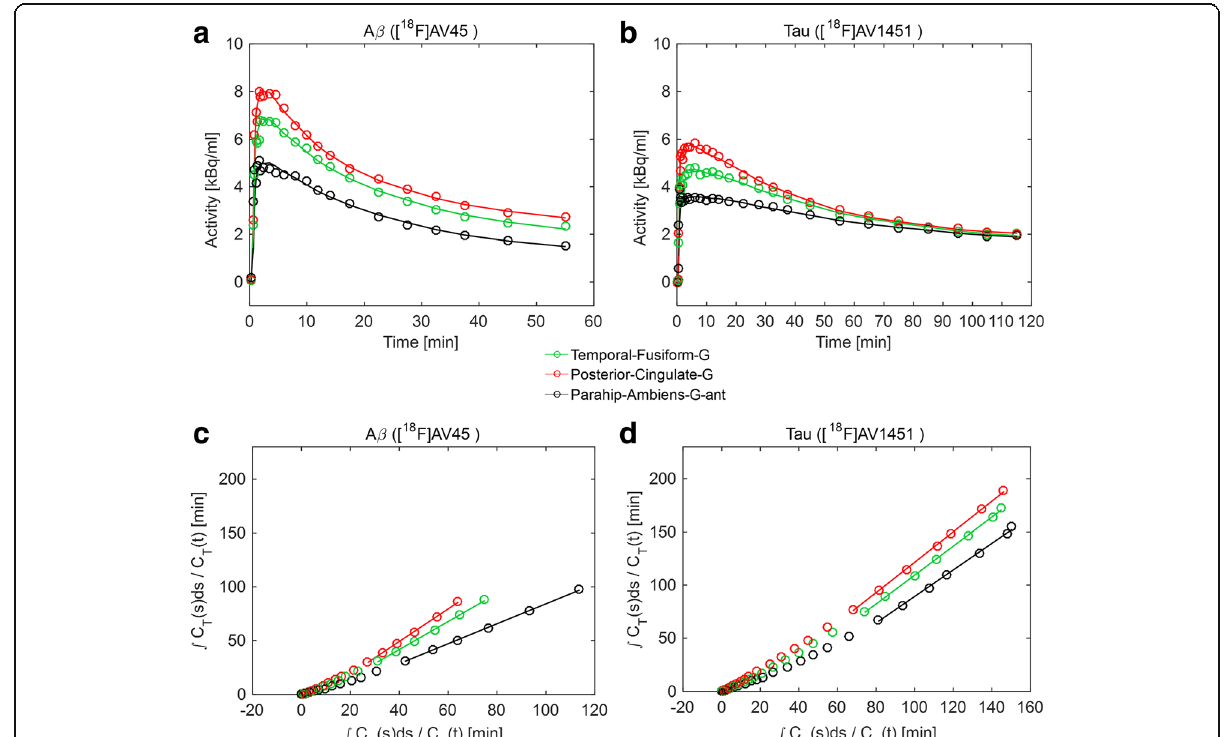
Fig. 1 SRTM ( a , b ) and reference Logan graphical analysis model ( c , d ) fit (solid line) to TACs (circles) of three example ROIs with different activity levels for A β ( a , c ; t * = 20) and tau ( b , d ; t * = 50) dynamic PET